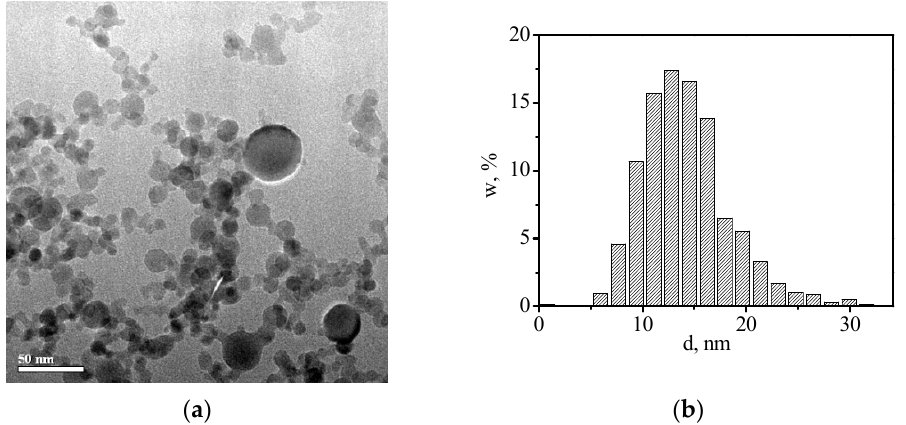
Figure 1. ( a ) TEM image of the (La x Y 1 − x ) 2 O 3 nanoparticles and ( b ) the particles size distribution by number.